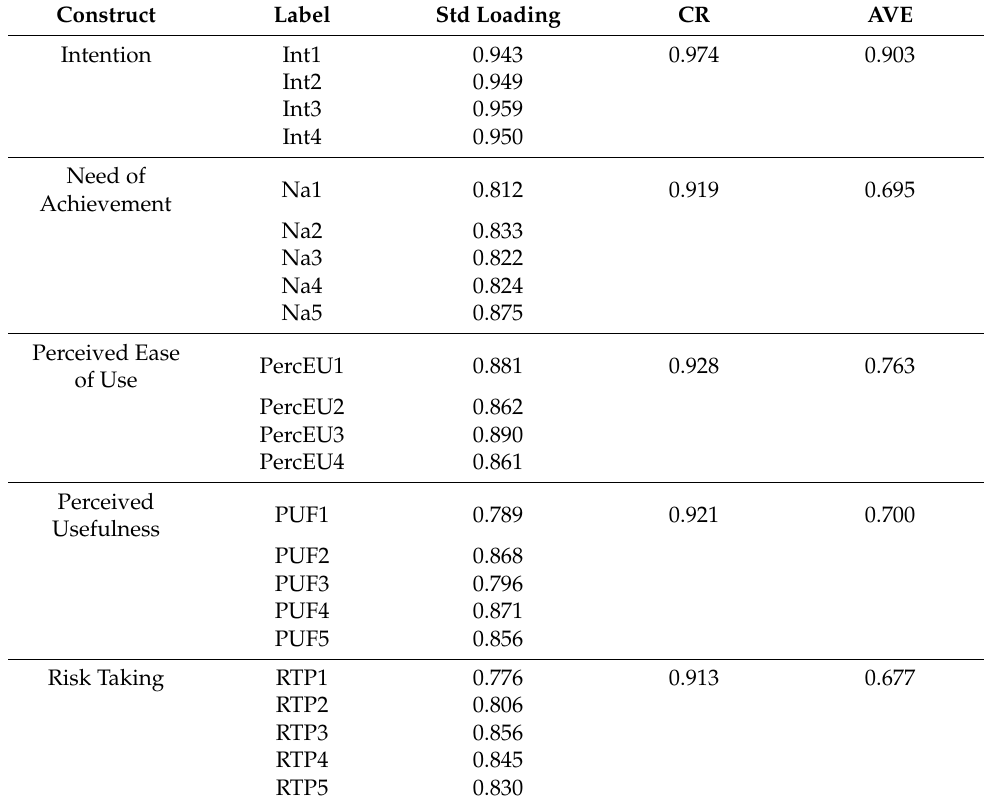
Table 3. Construct reliability and convergent